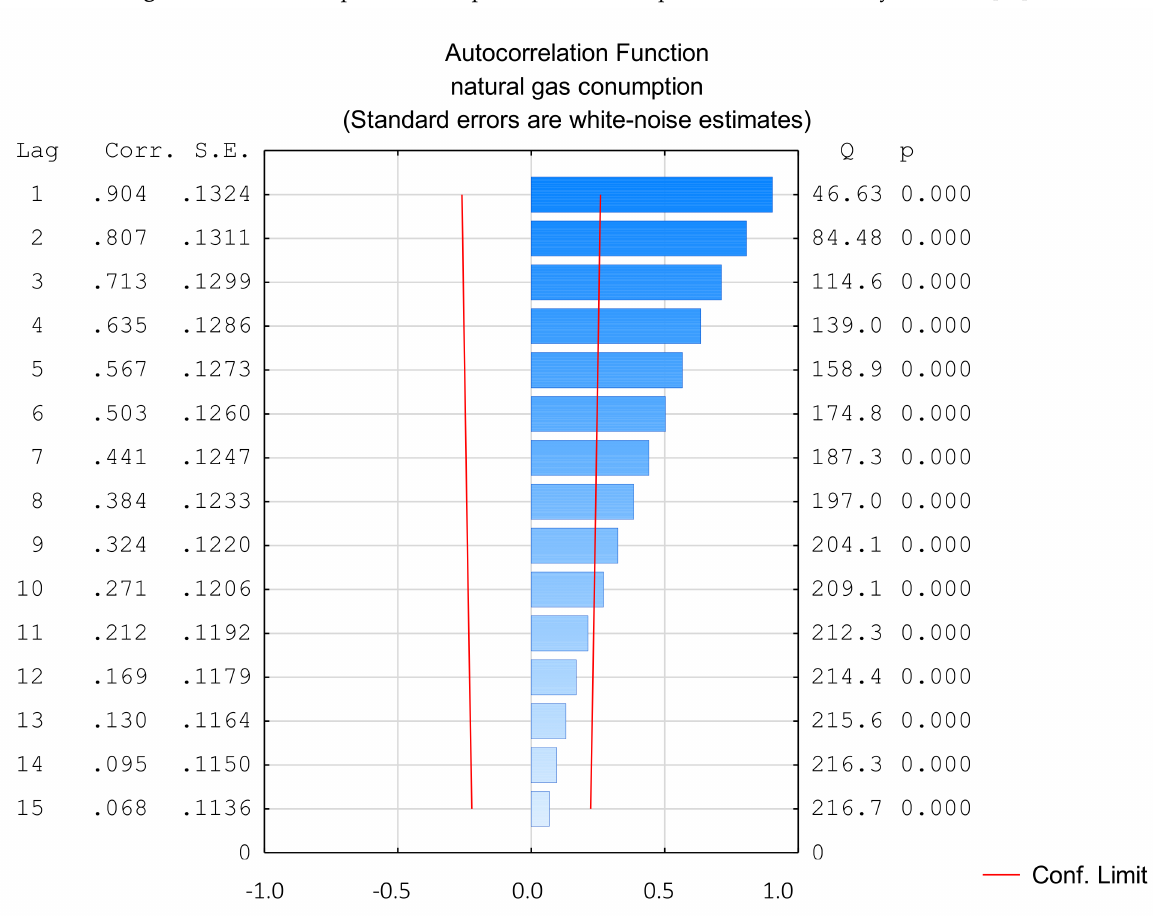
Figure 4. Autocorrelation function; own study based on